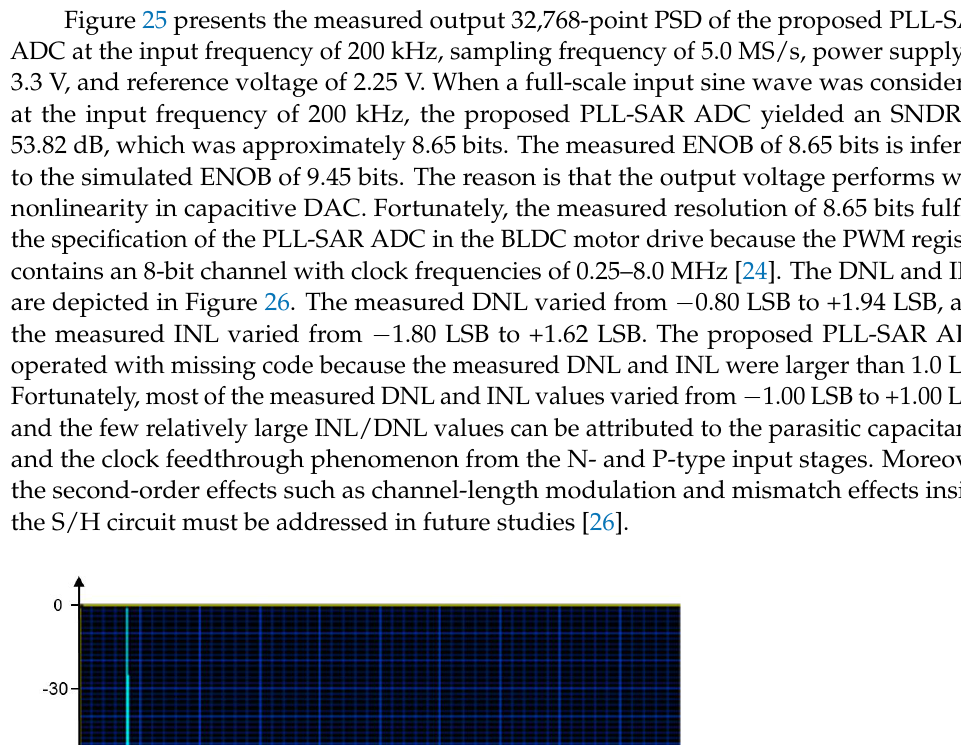
Figure 24. Measured waveforms of input signal V a and feedback signal V b of the proposed PLL.